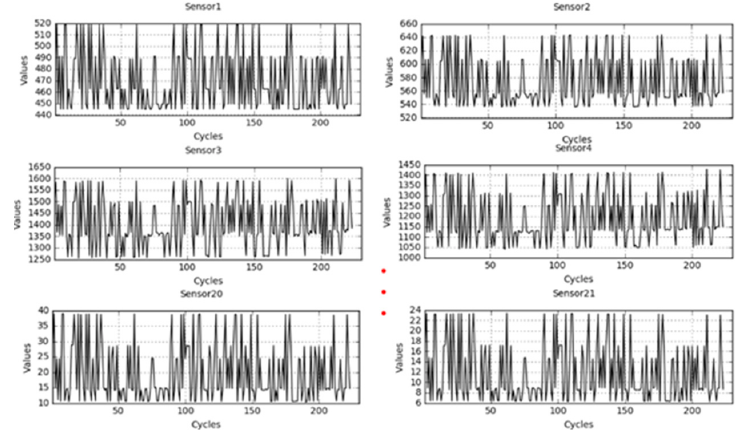
Figure 7. Diagram of turbine engine sensor parameter.